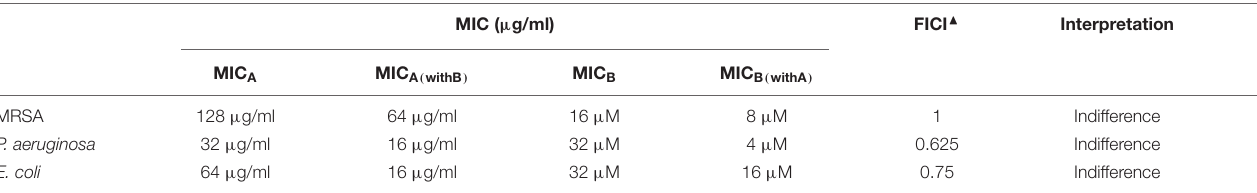
TABLE 2 | Etest minimum inhibitory concentrations (median and range) of ceftriaxone sodium and PPIX-MED alone and in